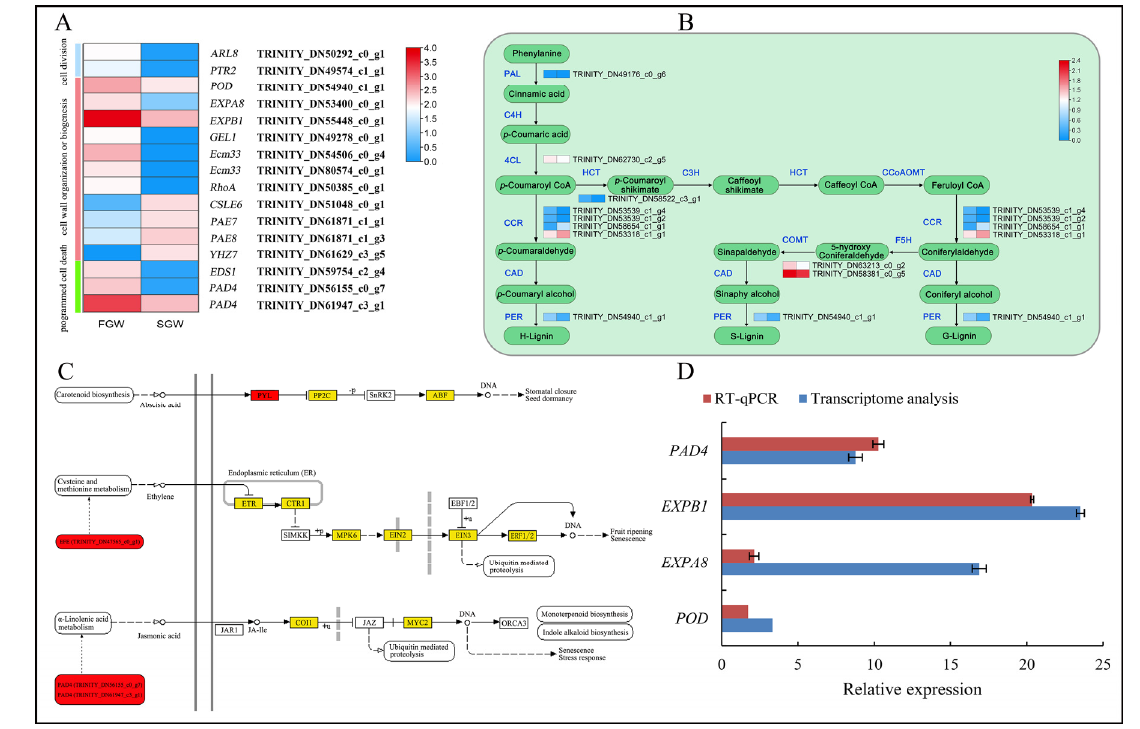
Figure 4. Characterization of differentially expressed genes related to cell wall organization or biogenesis. ( A ) Expression analysis of 16 secondary growth-related DEGs in FGW and SGW. The expression levels of genes are indicated according to the value of log10(FPKM+1), as shown in the color bar. ( B ) Expressed genes involved in lignin biosynthesis pathway of P. massoniana . Key genes or enzymes were displayed at nodes. According to the value of log10(FPKM+1), the expression of node matching and DEGs is marked at the side of each node, as shown in the color bar. The left and right columns of expression pa tt ern represent FGW and SGW, respectively. PAL: phenylalanine am- monia-lyase; C4H: cinnamate 4-hydroxylase; 4CL: 4-coumarate: CoA ligase; CCR: cinnamoyl-CoA reductase; CAD: cinnamyl alcohol dehydrogenase; PER: peroxidase; HCT: hydroxycinnamoyl-CoA: shikimate hydroxycinnamoyl transferase; C3 ′ H: p-coumaroyl shikimate 3 ′ -hydroxylase; CCoAOMT: ca ff eoyl-CoA O-methyl transferase; F5H: ferulic acid/coniferaldehyde/coniferyl alcohol 5-hydroxylase; and COMT: ca ff eic acid O-methyltransferase. ( C ) Endogenous hormone biosynthesis and signal transduction of abscisic acid and ethylene. The red box indicates that the gene is signi fi cantly up-regulated. The yellow box indicates that gene expression is insigni fi cantly induced. ( D ) RT-qPCR validation of DEGs.